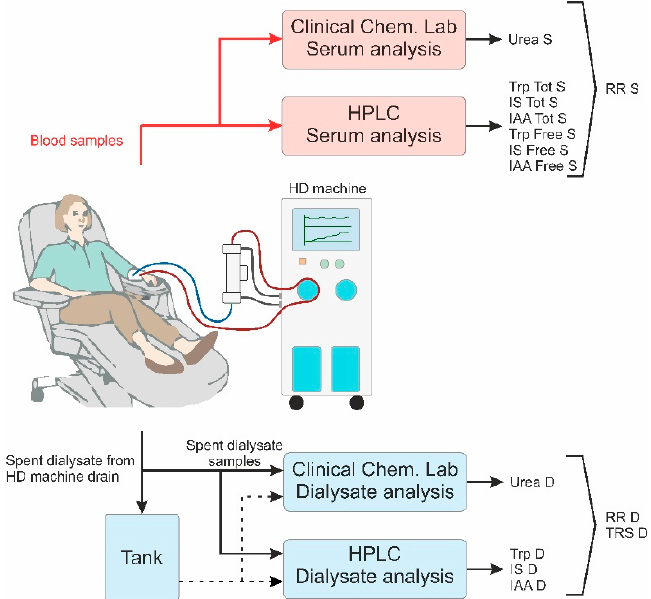
Figure 6. The schematic clinical set-up, sample collection, and analysis during the clinical studies.